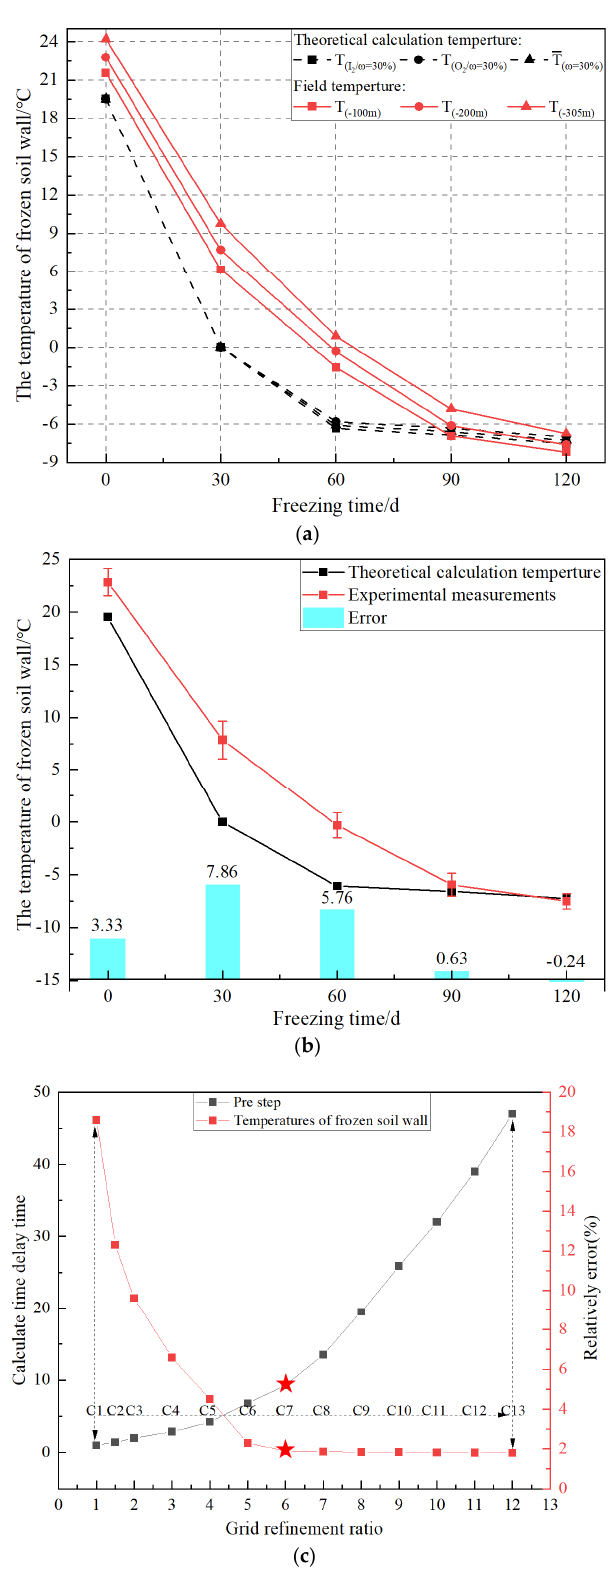
Figure 7. Verification for the numerical calculation model using the experimental measurements and the theoretical calculation temperature of frozen soil wall: ( a ) value comparison, ( b ) error anal ‐ ysis, ( c ) evaluation for the grid sensitivity test.